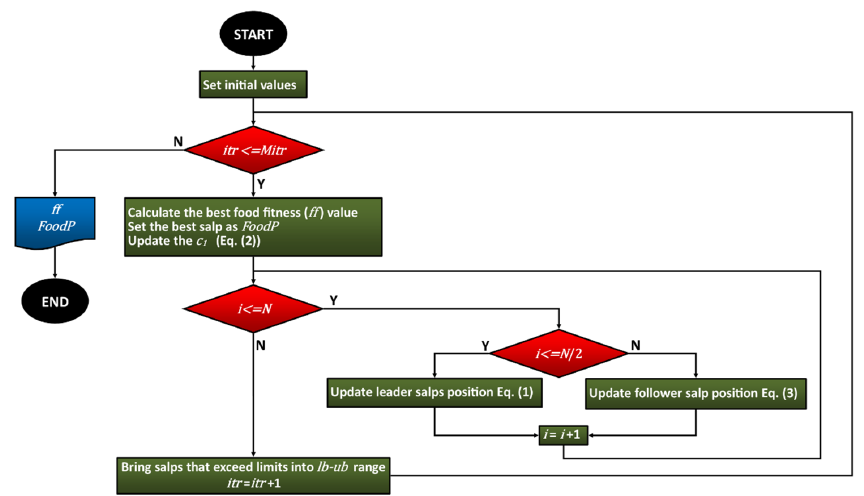
Fig. 1 Flowchart of SSA -based on multiple leader salps- (Faris et al., 2016a; Mirjalili, 2018; Wang et al., 2018; Zhang et al.,